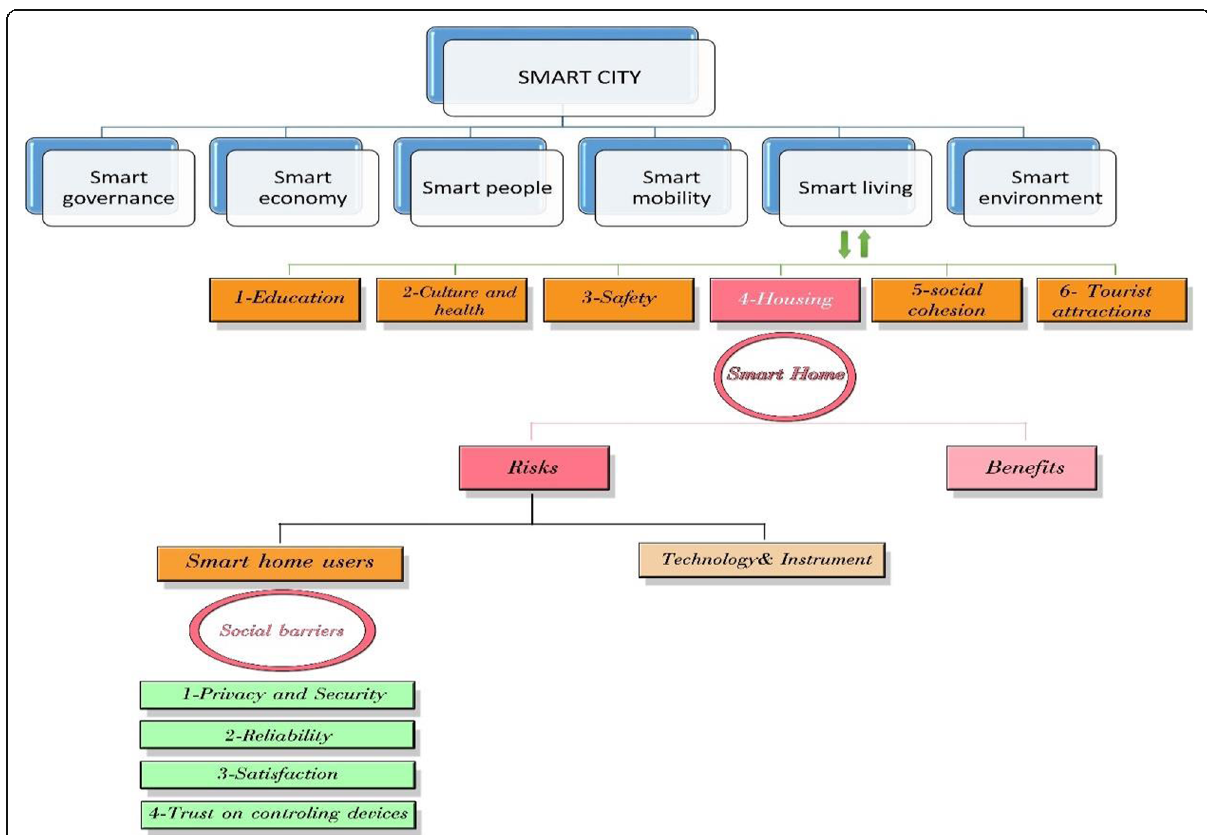
Fig. 1 Conceptual model. Source “ by the author ”